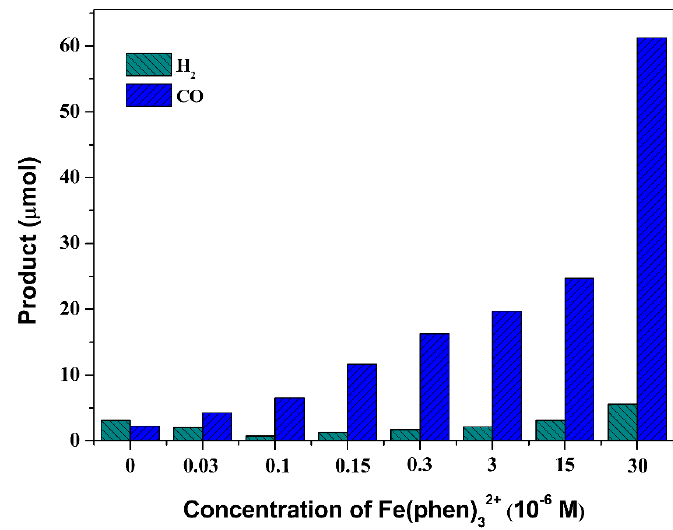
Figure 1. Catalyst-concentration dependence of CO and H 2 production in 4 mL CO 2 -saturated DMF/TEOA solution ( v/v , 7:1) containing 6.7 × 10 − 4 M Ru(bpy) 32+ and 0.022 M BIH after bright LED visible-light irradiation for 2 h at 298 K. Table 1. Controlled experimental results from Fe(phen) 3 Cl 2 ( 1 ) for photocatalytic conversion of CO 2 to CO.